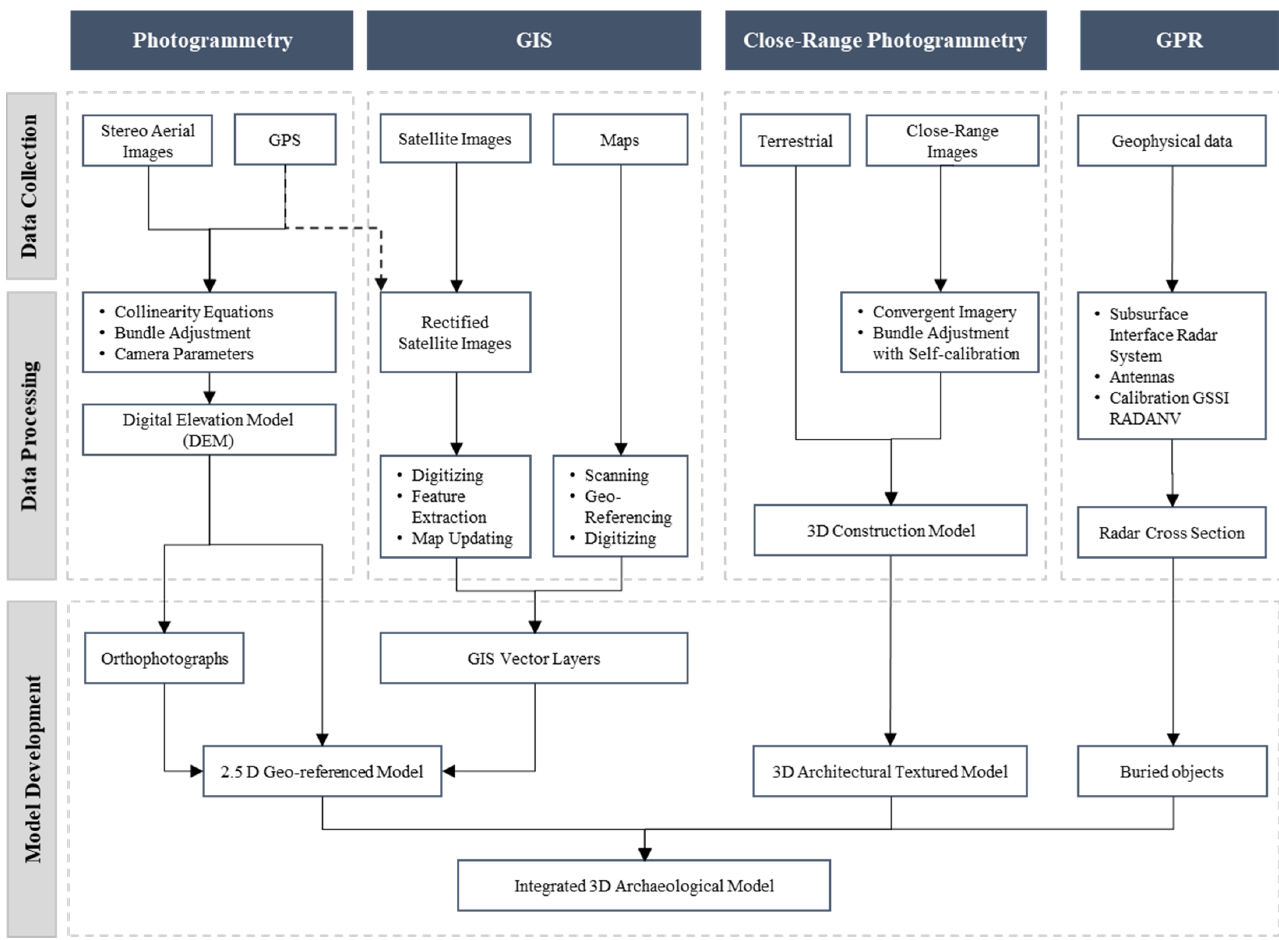
Figure 4. Flowchart of the proposed methodology.